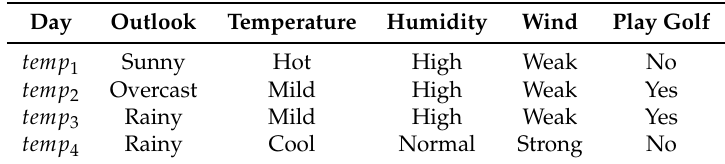
( MV ( g cd ( MV ( g cd ( u )))))) , temp 1 0.5, l 3 0.5, l 2 0.5, l 1